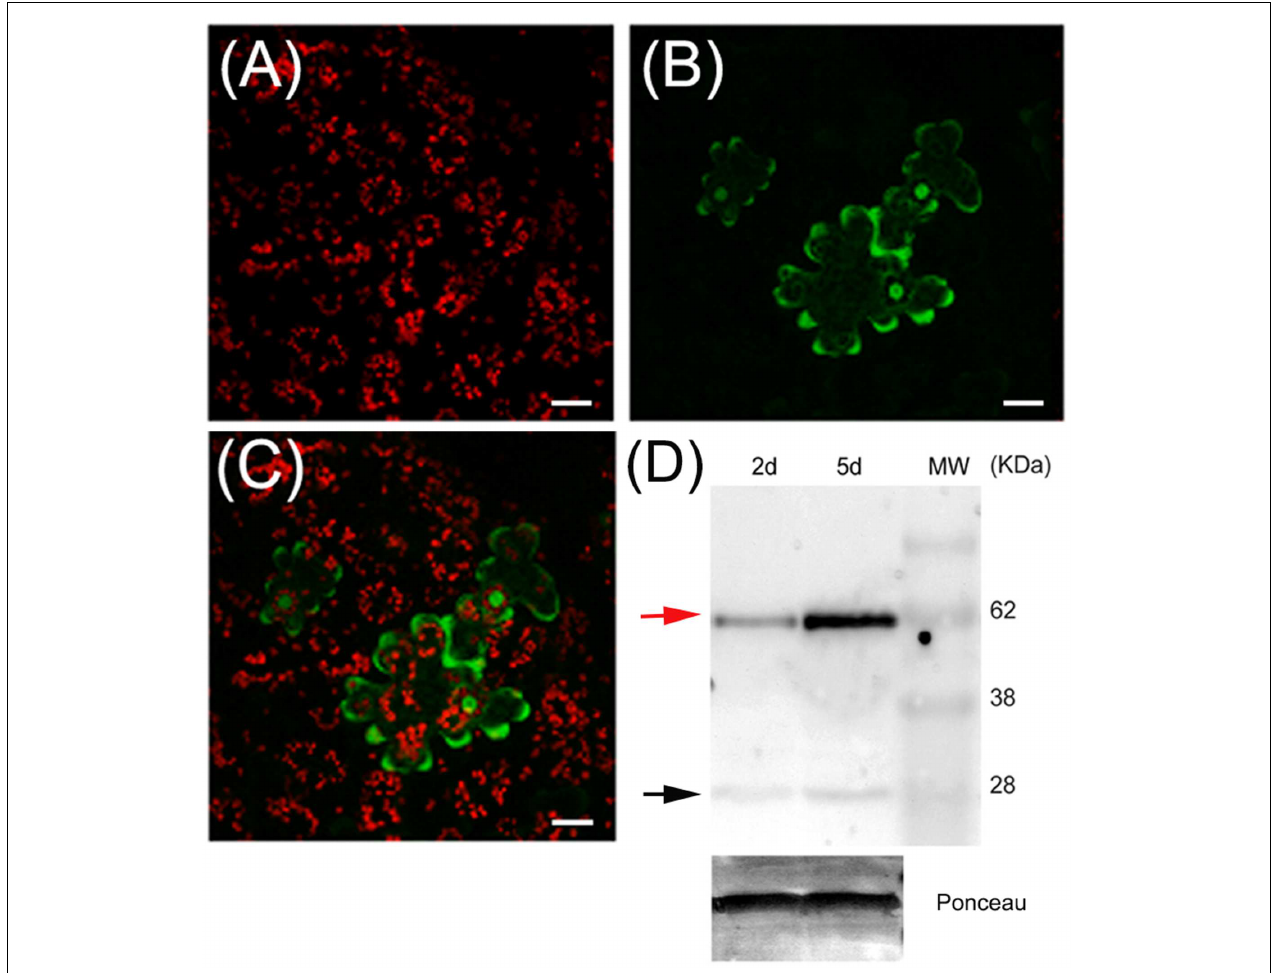
FIGURE 2 | Subcellular localization of PpPR-10 in agroinfiltrated tobacco leaves. Confocal microscopy images of tobacco leaves agroinfiltrated with the 35S:PpPR-10-GFP construct. Leaves have been imaged 2 days after agroinfiltration by confocal microscopy. Red fluorescence belongs to chlorophyll in chloroplasts (A) , green fluorescence belongs to GFP (B) , and merged fluorescences are shown in (C) . (D) Immunoblot detection of PpPR-10-GFP fusion protein (red arrow) in agroinfiltrated tobacco leaves, showing that the signal is mostly derived from the fusion protein. Ten micrograms of total soluble proteins were separated in SDS-PAGE and Western blot analysis was performed using an antibody for GFP. The 27 kDa protein corresponds to cleaved GFP (black arrow). The scale bars represent 20 µ m.